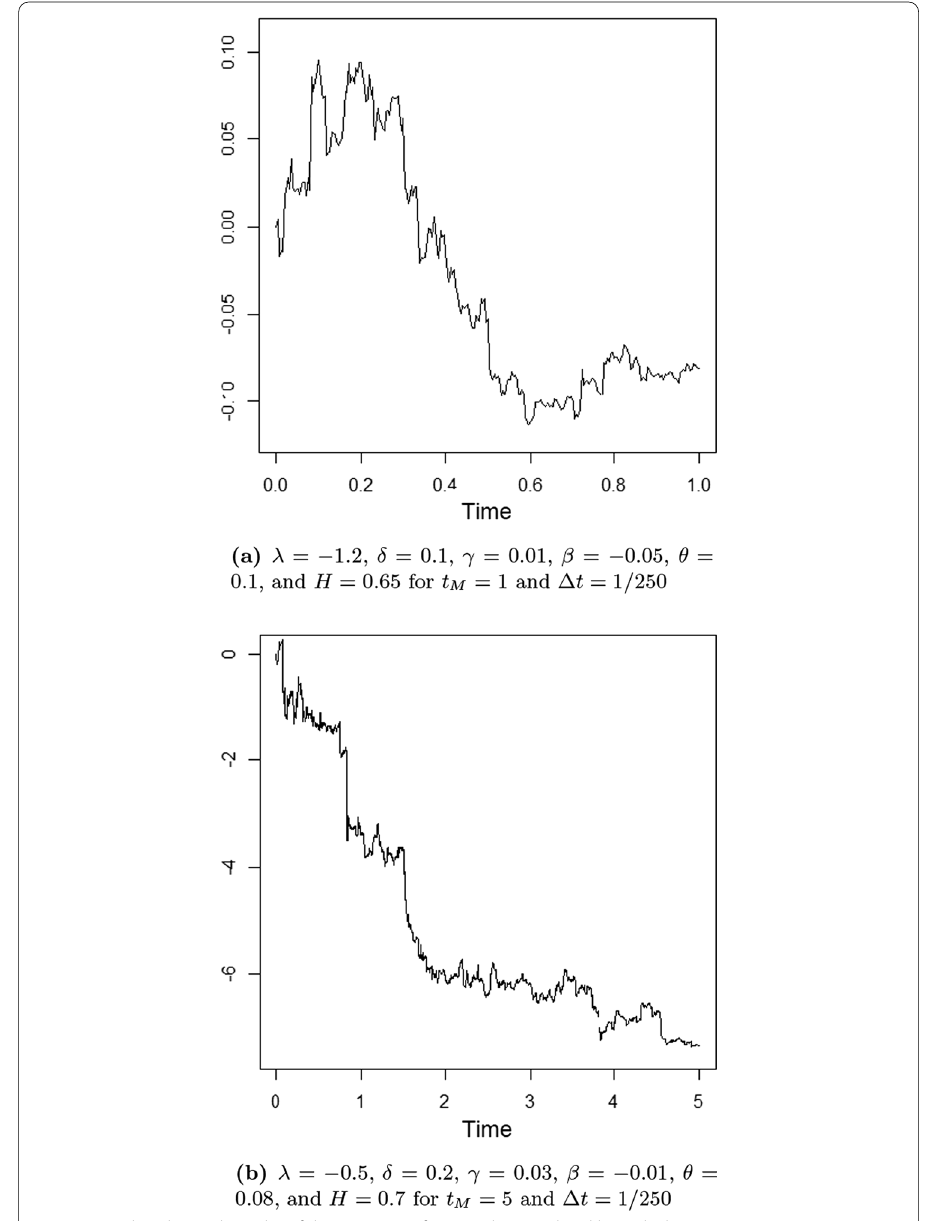
Fig. 2 Simulated sample paths of the univariate fractional generalized hyperbolic process